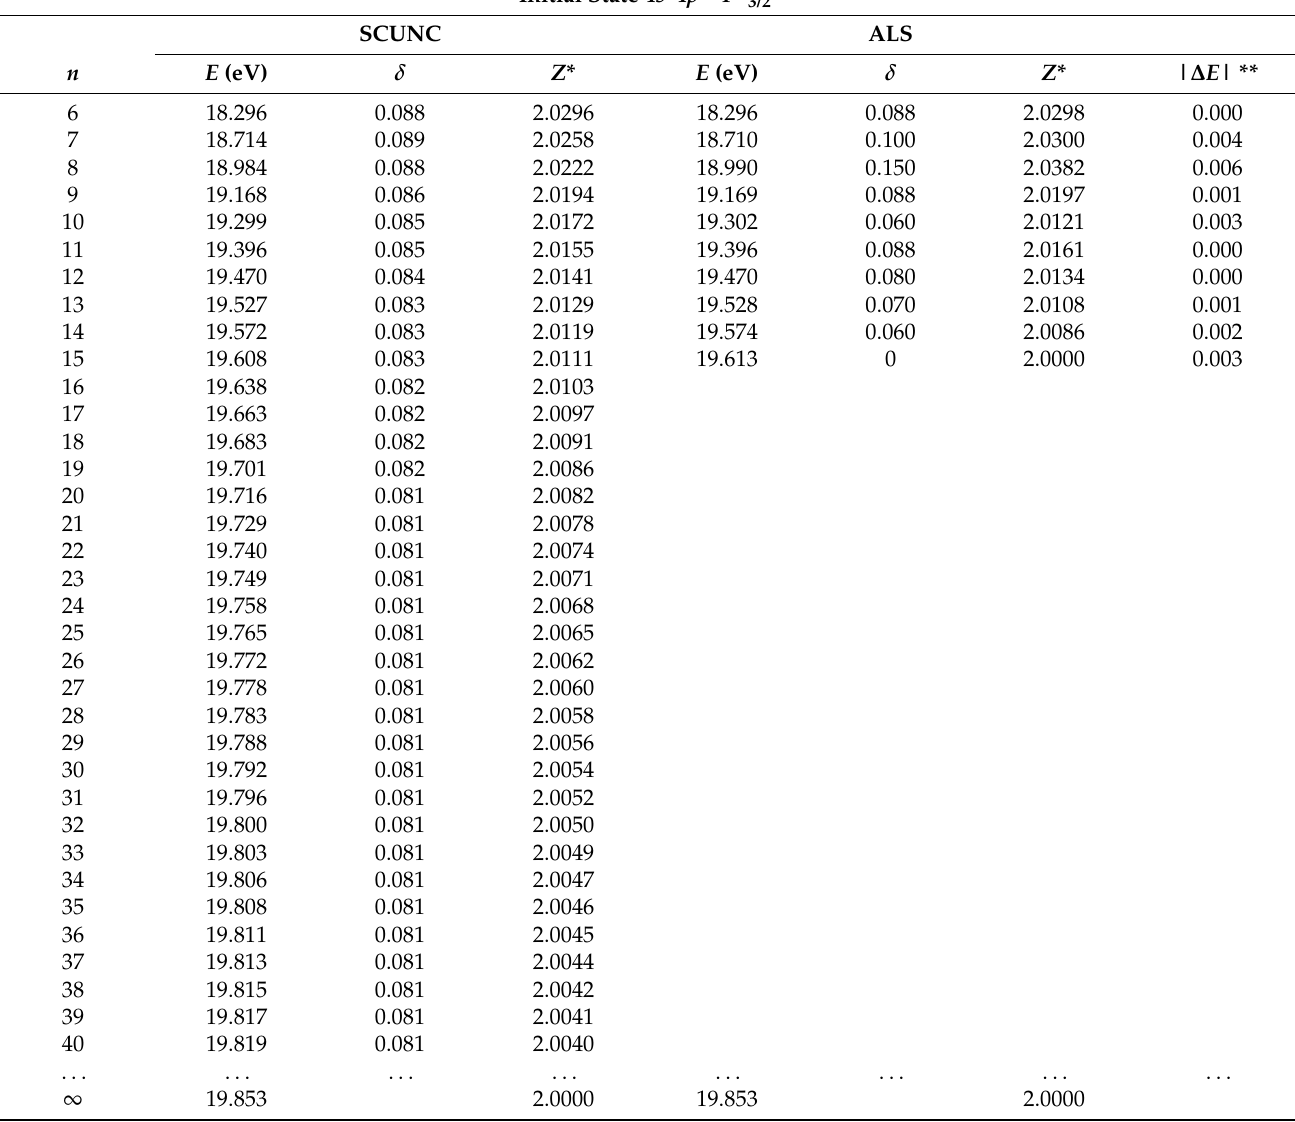
Table 1. Energy resonances ( E ), quantum defect ( δ ) and effective charge ( Z *) of the 4 s 2 4 p 2 ( 1 D 2 ) nd ( 2 S ) Rydberg series originating from the 4 s 2 4 p 3 2 P ◦ 3/2 metastable state of Se + converging to the 1 D 2 series limit in Se 2+ . The present results (SCUNC) are compared with the experimental data from ALS measurements [6]. The uncertainties in the experimental energies are stated to be ± 0.010 eV. The value of Z core = 2.0000 is indicated in the last line of the table, f 1 ( 1 D 2 ; 2 P ◦ 3/2 ) = − 0.148 ± 0.033 with ν =